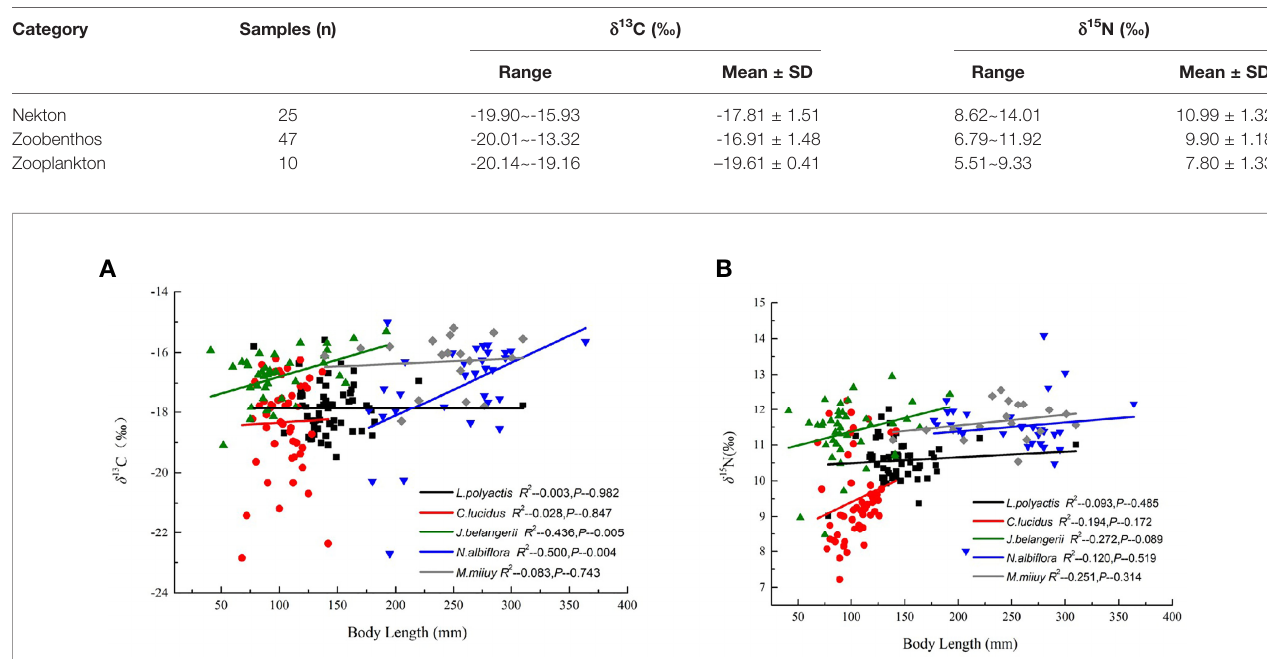
FIGURE 2 | Correlation of body length with d 13 C and d 15 N values of fi ve sciaenid fi sh species collected form the Zhoushan Archipelago between 2019 and 2021.